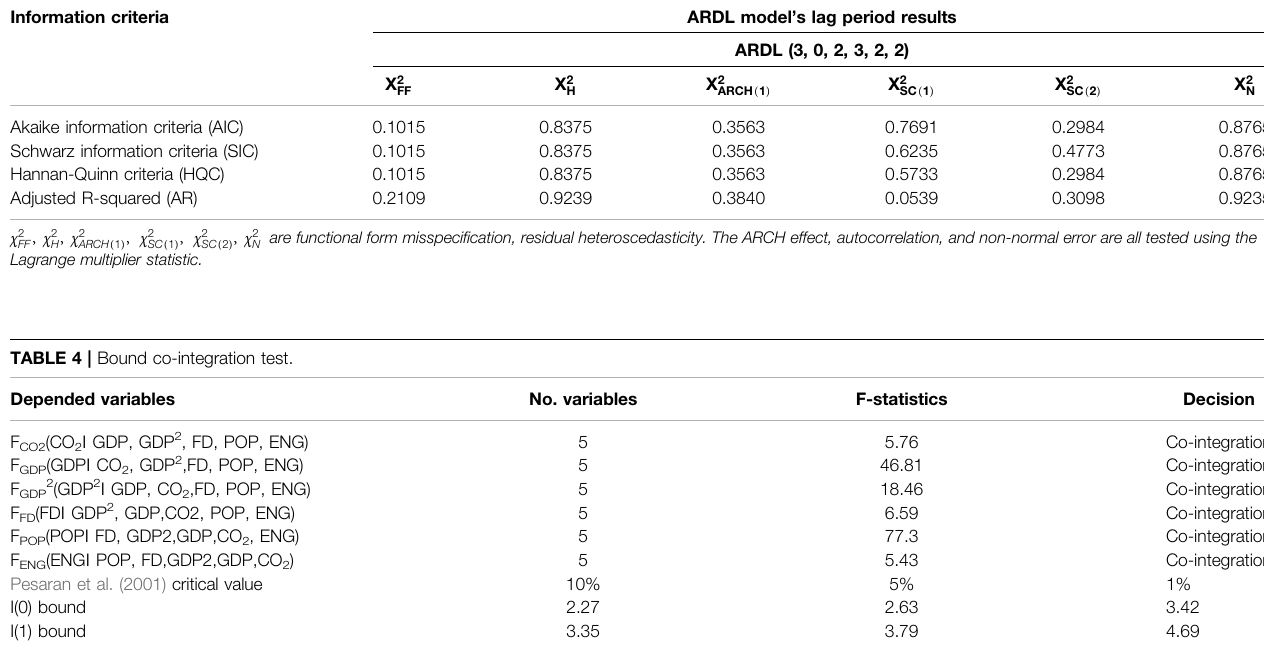
TABLE 3 | Model selection criteria.